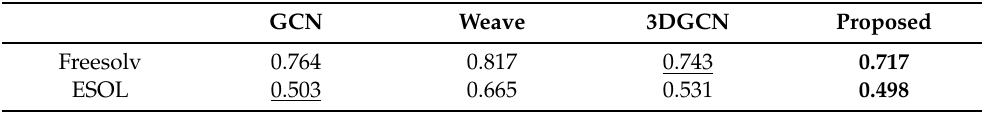
Table 2. Averages of MAE over 10 trials (Bold and underline are the best and the second-best,